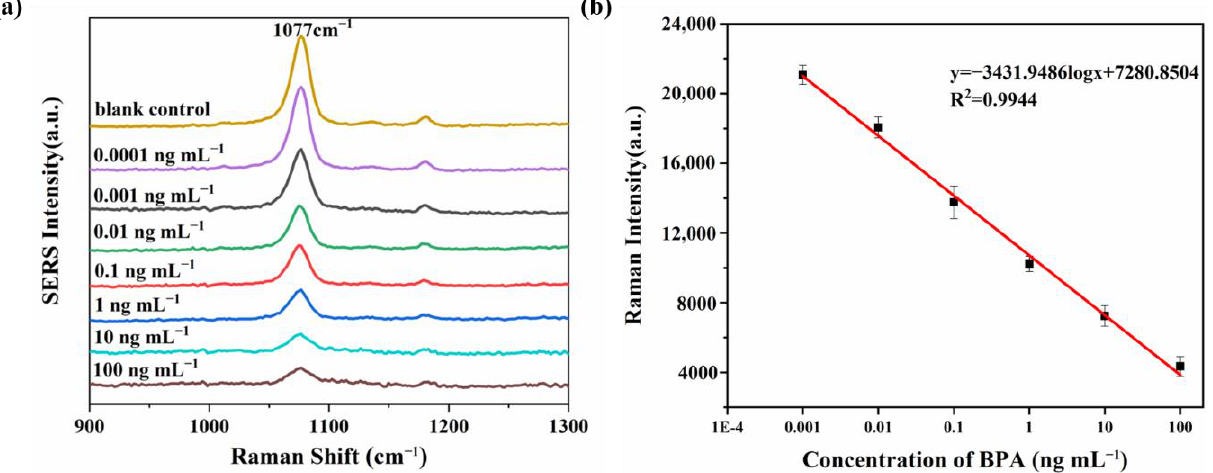
Figure 5. ( a ) Signal intensities of the different concentrations of BPA (from top to bottom 0, 0.0001, 0.001, 0.01, 0.1, 1, 10, 100 ng mL −1 ) in the surface-enhanced Raman spectra. ( b ) Calibration curve. Error bars indicate the standard deviation of the repeated experiments.